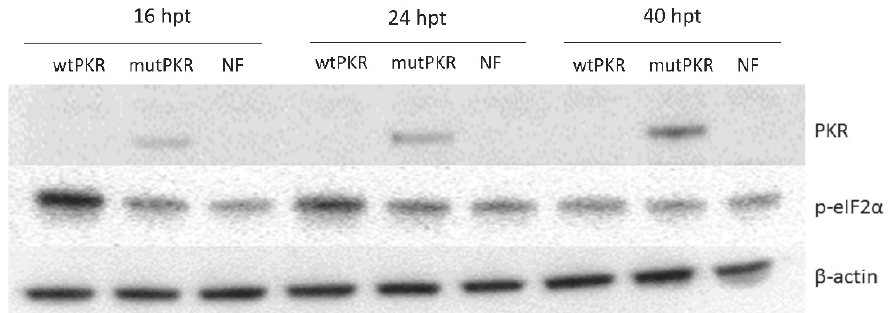
Figure 1. Expression of protein kinase R (PKR), phosphorylated eIF2 α (p-eIF2 α ), and β -actin in Epithelioma papulosum cyprini (EPC) cells transfected with the wild type pcDNA-wtcarpPKR (wtPKR) and mutant pcDNA-mutcarpPKR (mutPKR), respectively. Negative control, non-transfected cells, were NF. Samples were analyzed at three time-points, 16, 24, and 40 h post transfection (hpt). PKR was not detected at any time point in wtPKR transfected cells, but positive in mutPKR cells, progressively increasing from 16 to 40 hpt. eIF2 α was phosphorylated wtPKR cells, decreasing from 16 to 40 hpt. No difference in the phosphorylation levels of eIF2 α between mutPKR and NF. β -actin was